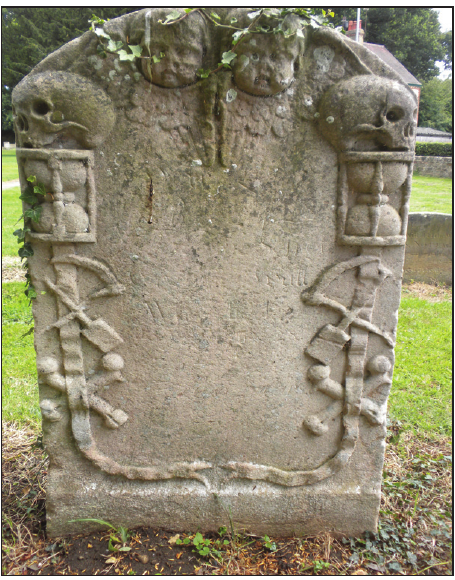
Figure 4: Tombstone with skull, hourglass, crossed scythes and shovels, topped with two cherubs, not looking entirely happy. All